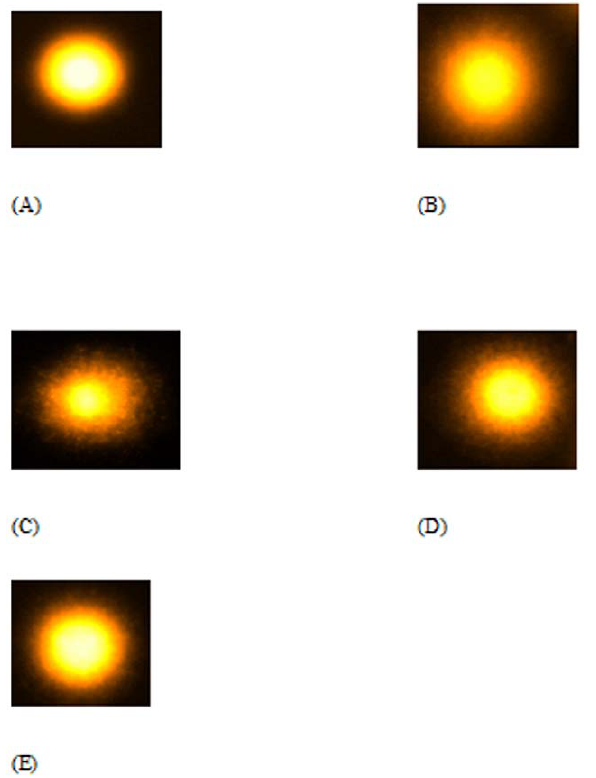
Figure 2. Showing the average comet picture of liver from different treated groups of mice. Average comet picture of liver samples of various treated mice groups divided as (A) Control as Group I (B) Riboflavin treated as Group II (C) Cisplatin treated as Group III (D) Combination I as Group IV (E) Combination II as Group V.